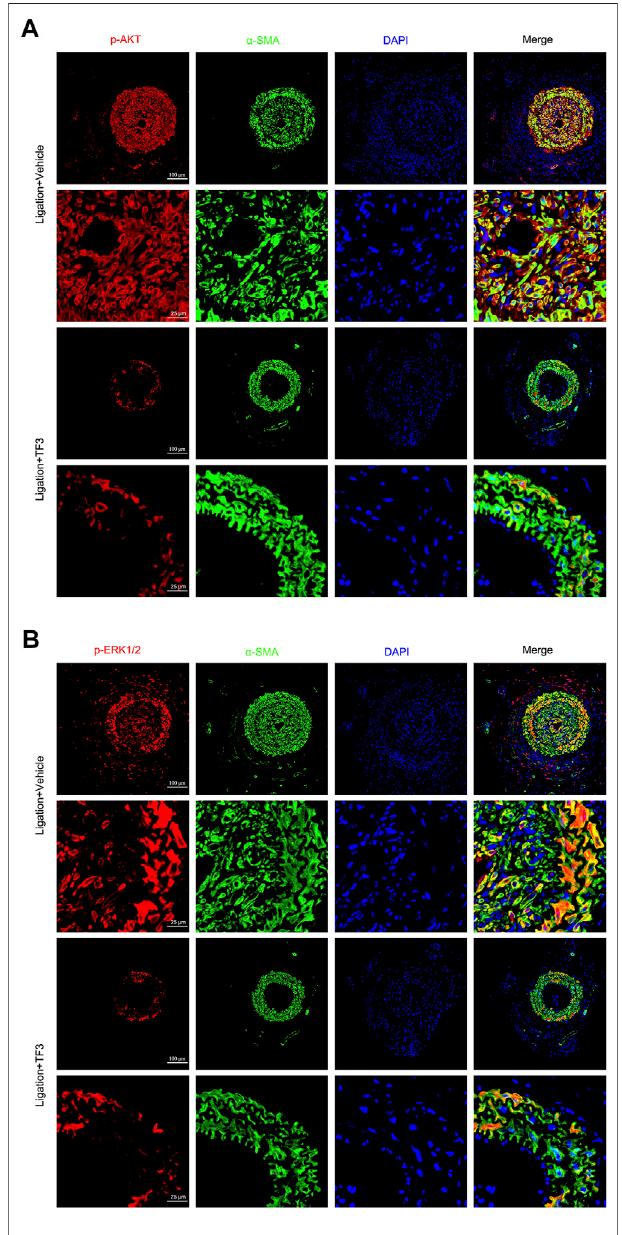
FIGURE 7 | Thea fl avin-3,3 ′ -digallate (TF3) suppresses the activation of AKT and ERK1/2 during carotid artery ligation – induced neointimal hyperplasia. TF3 (10 mg/kg) or vehicle was intraperitoneally injected after carotid artery ligation. (A) Immuno fl uorescence staining of p-AKT (red), α -SMA (green), and DAPI (blue) (above) and their enlarged view (below) are shown. (B) Immuno fl uorescence staining of p-ERK (red), α -SMA (green), and DAPI (blue) (above) and their enlarged view (below) are shown. Scale bars, 100 and 25 μ m.